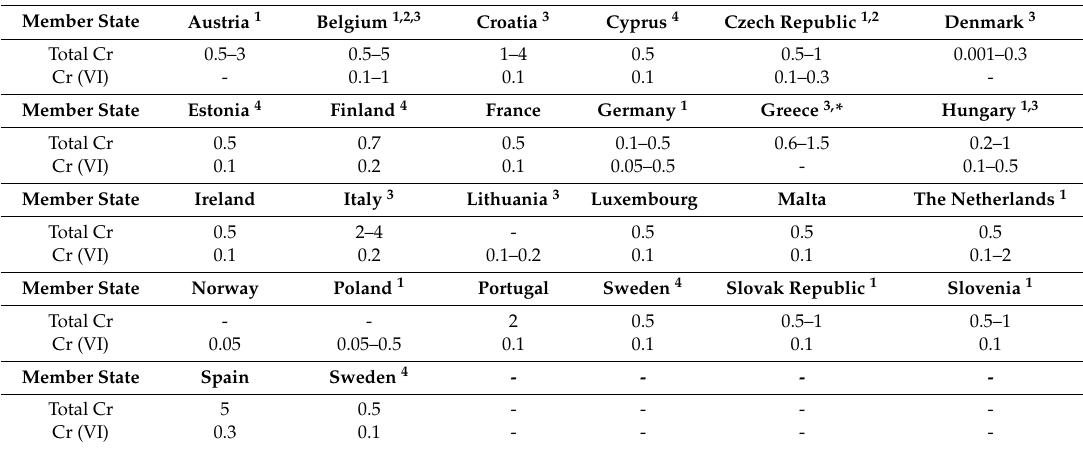
Table 1. National discharge limits for total Cr and Cr (VI) concentrations in wastewaters, expressed as mg L − 1 (adapted from